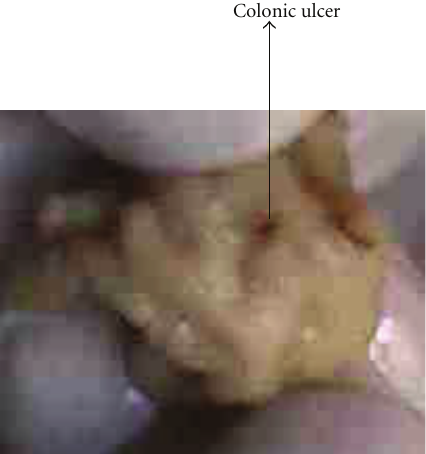
Figure 5: Colonic